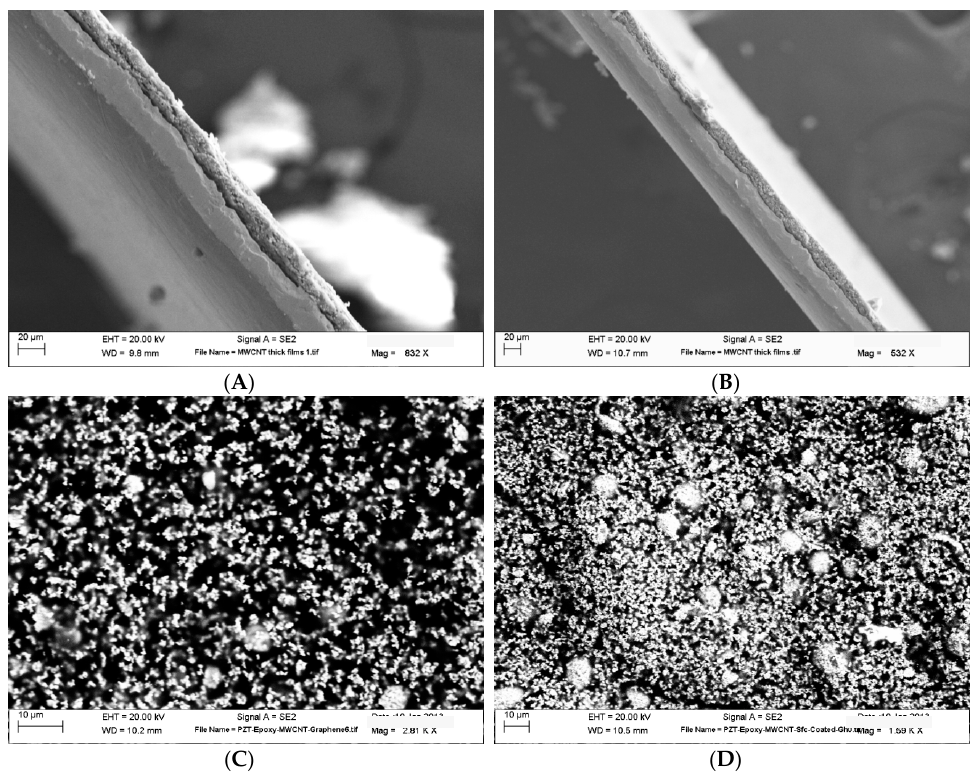
Figure 13. Cross-sectional SEM micrograph of a PZT-epoxy-MWCNT thick film with MWCNT volume fractions of ( A ) 0.04 (4%) and ( B ) 0.06 (6%) showing the thick film of thickness ~150 μ m spin coated over a flexible stainless substrate of thickness 20 μ m. SEM images ( C , D ) show the fractured surface of the three phase composite with MWCNT volume fractions of 0.04 (4%) and 0.06 (6%). Both images illustrate the distribution of the PZT clusters and MWCNT clusters in the epoxy matrix, where larger spherical elements of the image are PZT particles.